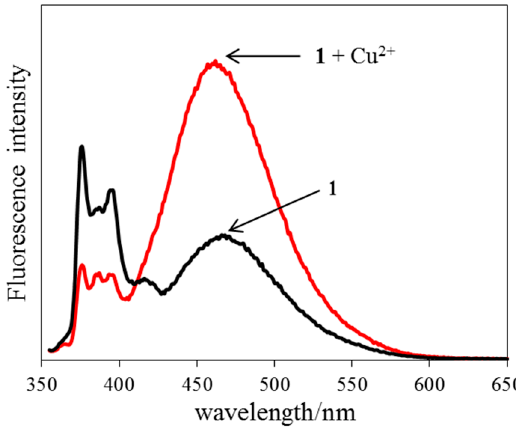
Figure 5. Fluorescence spectra of bispyrenyl malonate 1 (10 μ M) in the presence of 1 equiv. of Cu 2+ in acetonitrile/chloroform/methanol/water (7:1:1:1, v / v ) (excitation wavelength: λ ex = 344 nm).